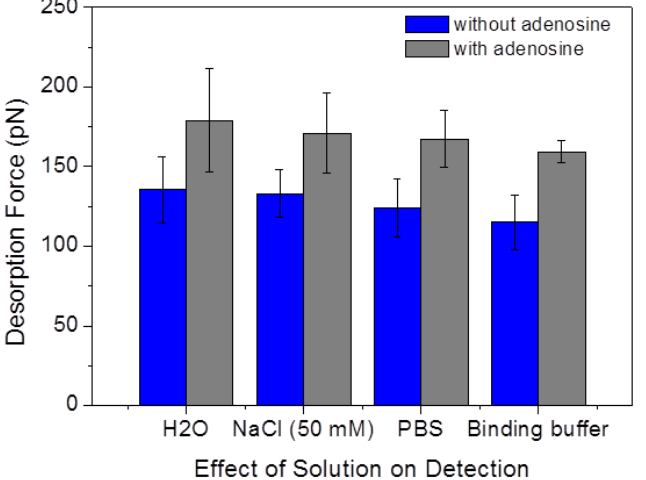
Figure 8. Mean aptamer/graphite desorption forces without and with adenosine (1 μM) in four different water